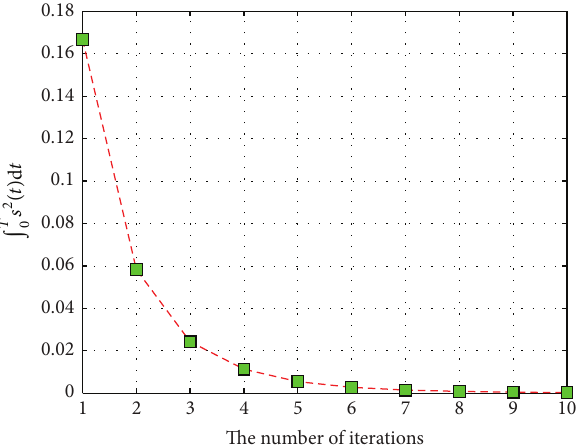
𝑇 𝑠 2 (𝑡) d 𝑡 versus the number of iterations in Case 1. 𝑘 0